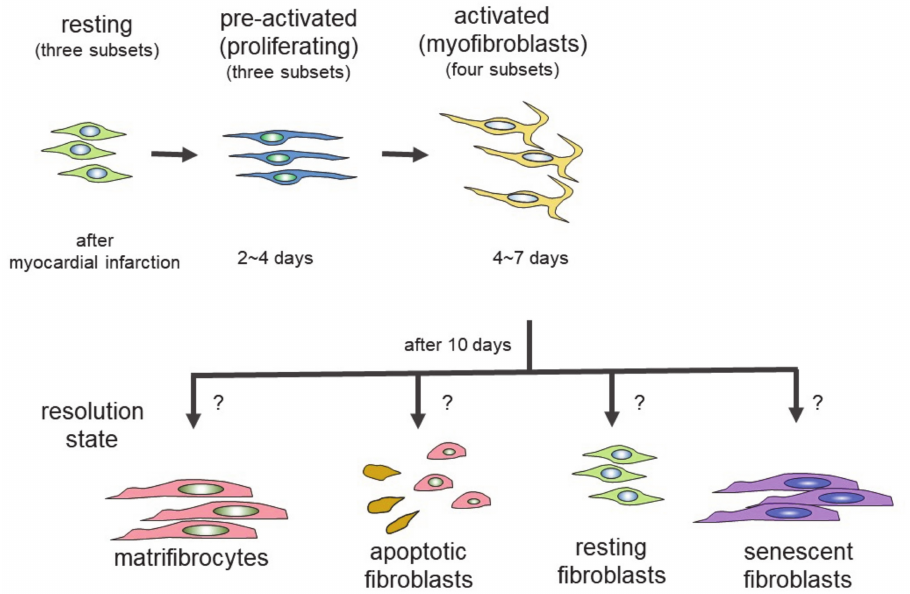
Figure 1. Differentiation of fibroblasts to several states of fibroblasts. Fibroblasts of each state have different proliferating activity and function. Scheme is based on two reports [33,34]. Table 1. Expression of marker proteins.